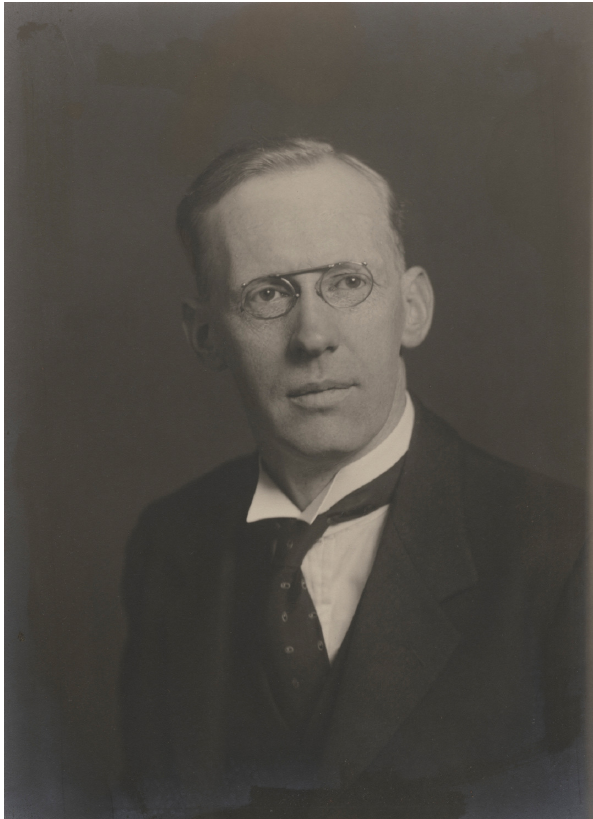
Figure 1. Joseph Proudman CBE, FRS (1888–1975) photographed in 1931 by Walter Stoneman. © National Portrait Gallery,